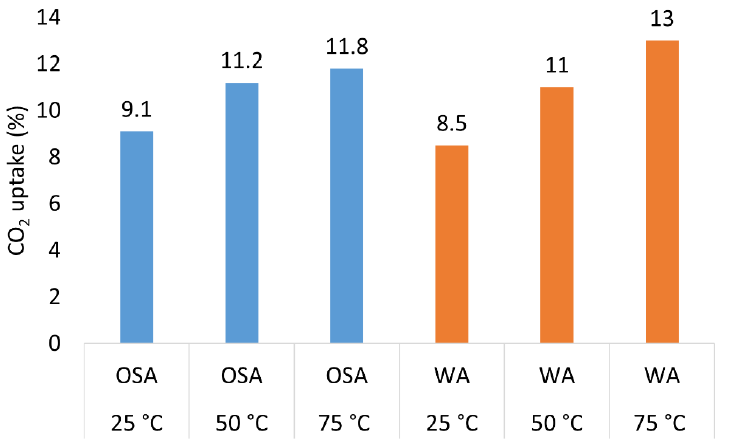
Figure 11. CO 2 uptake values at different temperatures (10 bar, 100% CO 2 , 150 kgf/cm 2 ) (Average values obtained from min. 4 samples (std. deviation < 3%)).